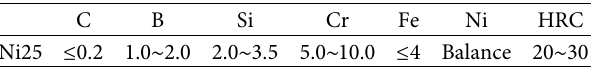
Table 3: The chemical composition of Ni25 (wt.%). C B